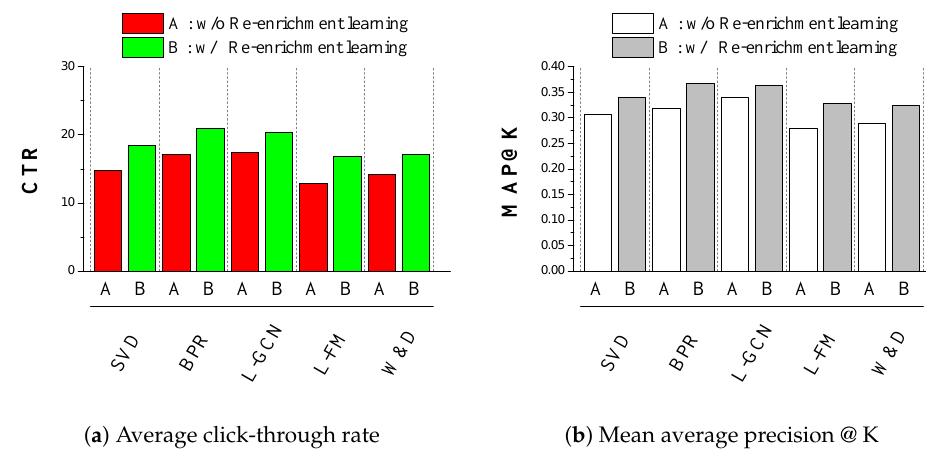
Figure 6. Visualization of A/B experiments on the MovieLens dataset. Table 2. The results of A/B experiments on the MovieLens